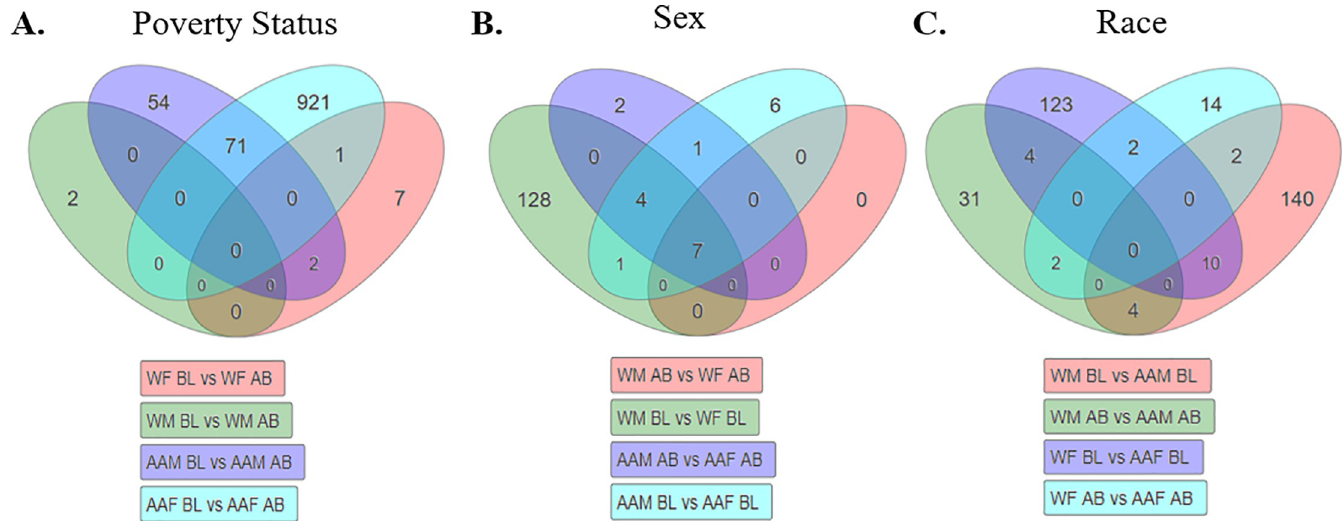
Fig 2. Gene expression profiles associated with poverty, sex, and race. DGE profiles of significant genes (|LogFC| > 0.6, FDR AdjPvalue < 0.3) in each comparison subgroup were compared by Venn diagram using iPathway Guide and stratified either by poverty status (A), Sex (B) or Race (C) to identify common and overlapping genes (N = 6/7 per group; see S1 Table for complete demographics). White females below poverty (WFBL) or above poverty (WFAB); white males below poverty (WMBL) or above (WMAB); African American males below poverty (AAMBL) or above (AAMAB); African American females below poverty (AAFBL) or above